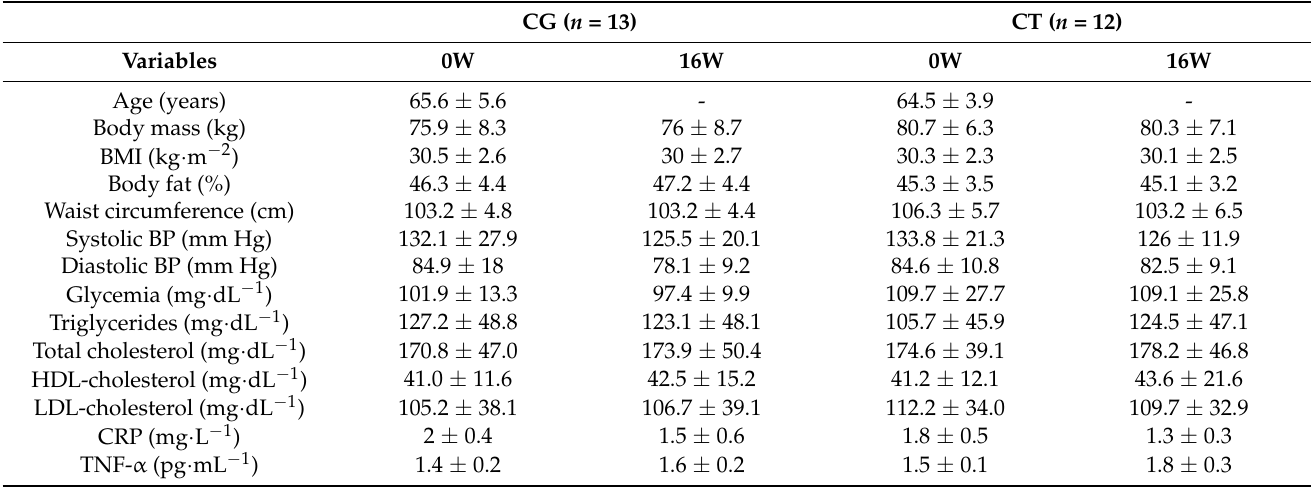
Table 1. Pre- and post-training characteristics of participants.